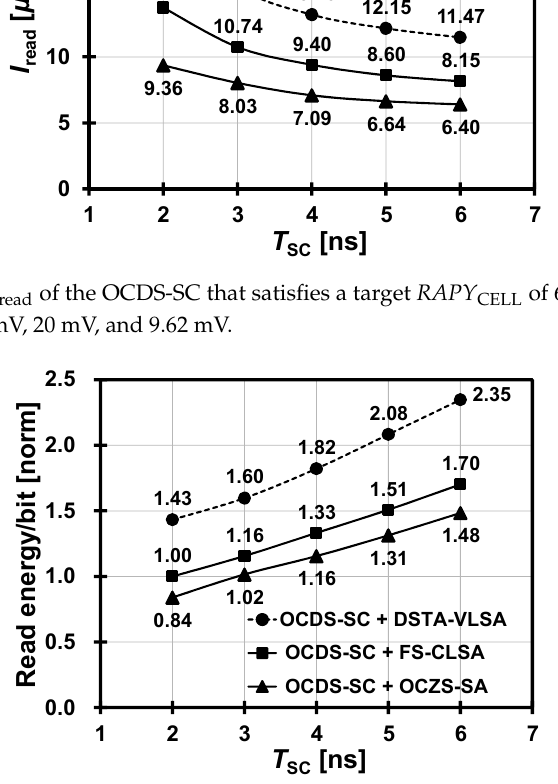
Figure 13. Normalized read energy per bit according to T SC in cases of OCDS-SC + DSTA-VLSA, OCDS-SC + FS-CLSA, and OCDS-SC + OCZS-SA.